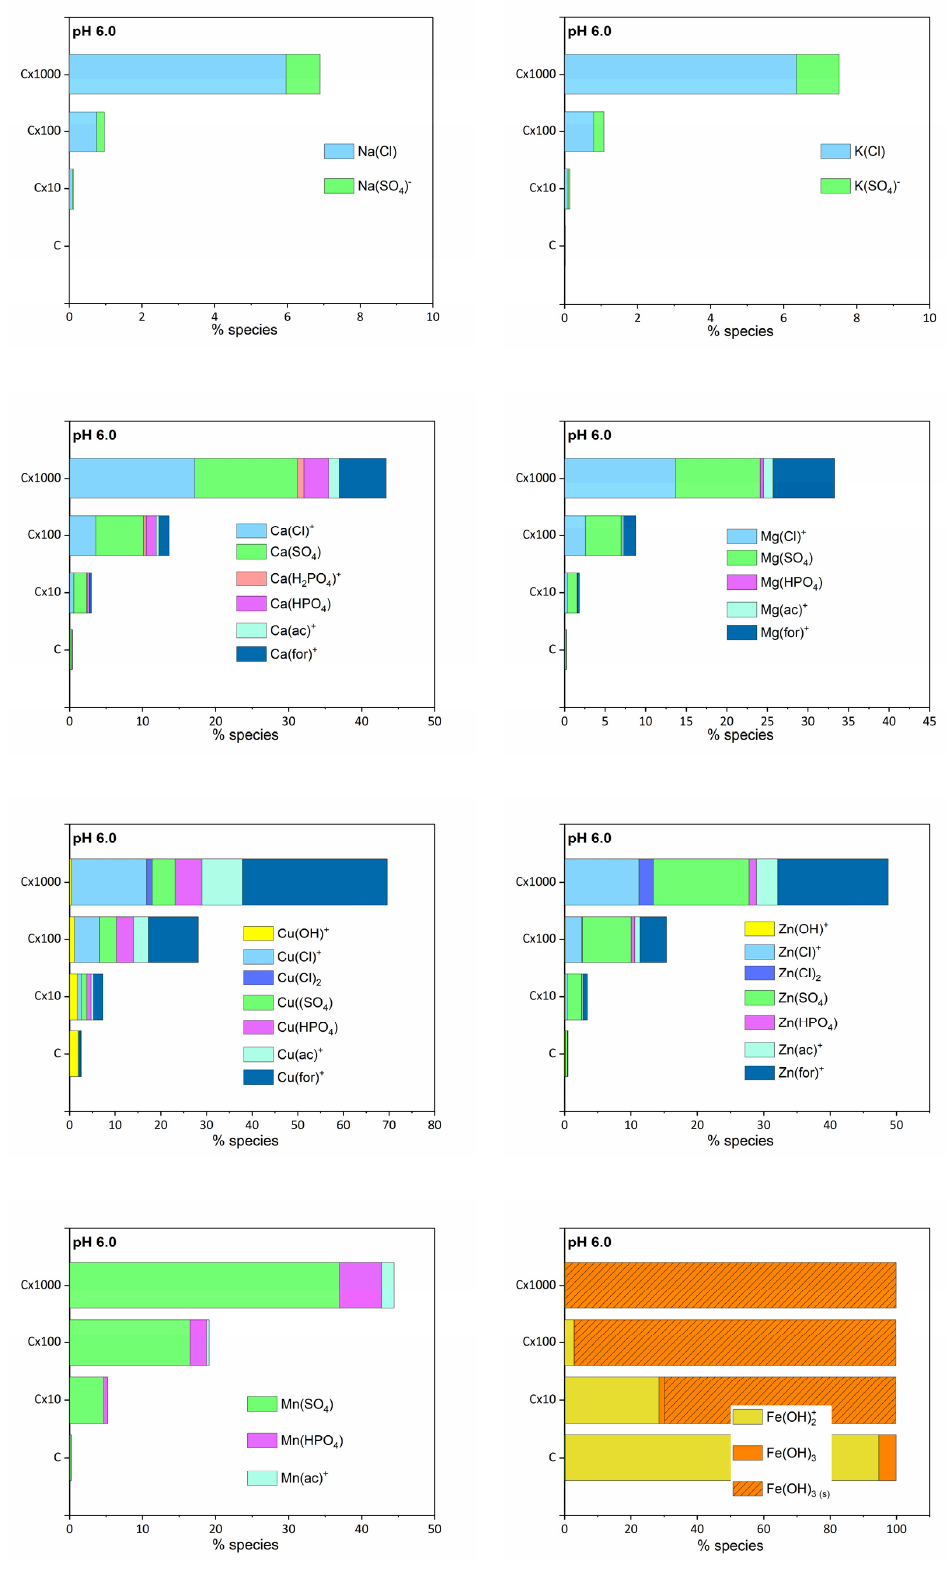
Figure 8. Percentages of cations involved in the different species as a function of the concentration level of the components, at pH 6.0. The concentrations are those of the atmospheric deposition sample D3-2 (C), or the same multiplied by a factor 10, 100, or